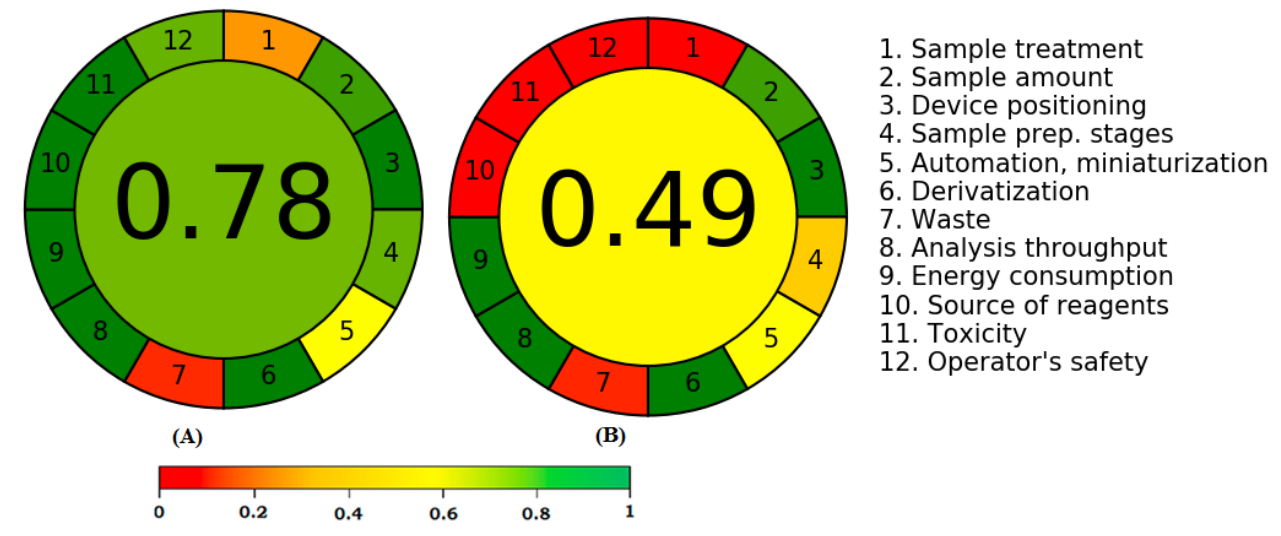
Figure 8. Analytical GREEnness (AGREE) indices for ( A ) sustainable and ( B ) conventional analytical assays.